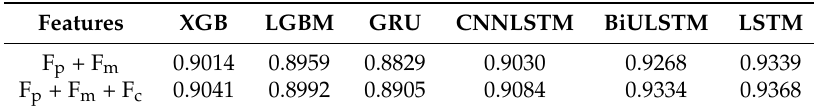
Table 4. Models’ average IA values with/without CMAQ